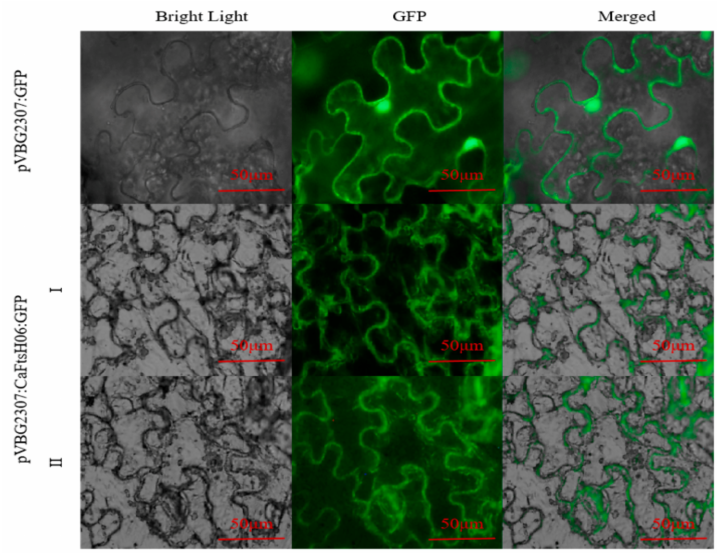
Figure 4. Analysis of the characteristics of CaFtsH06 protein’s subcellular localization. The local- ization of pVBG2307:CaFtsH6:GFP fusion protein in tobacco cells (I-II), with pVBG2307:GFP as a control. Bright light: cells in bright field; GFP: fluorescence of GFP protein under green fluorescence; merged: overlapped image of GFP and bright light. Bar = 50 µ